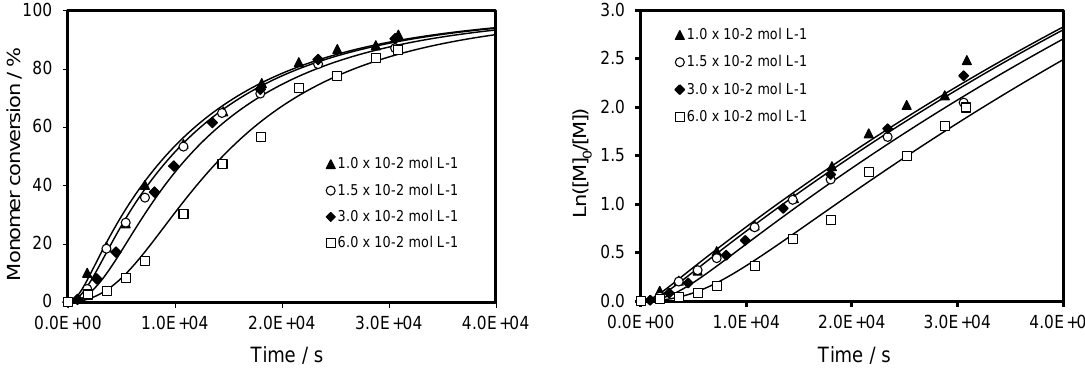
Figure 3. Evolution of monomer conversion and ln([M] 0 /[M]) versus reaction time for CPDB-mediated polymerization of TBDMSMA in toluene at 70 °C with initial concentration of CPDB ranging from 1.5 × 10 −2 to 6.0 × 10 −2 mol·L −1 . The graph compares predicted values (lines) with experimental data (points).